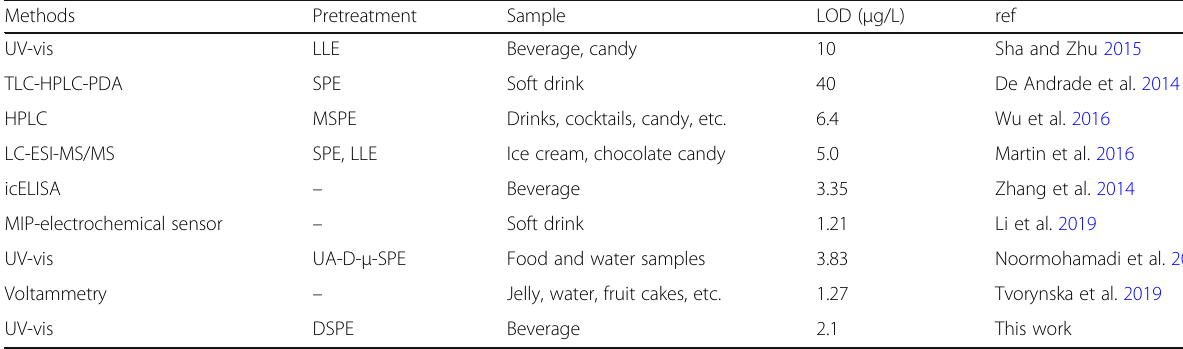
Table 1 Comparison of detection methods of amaranth